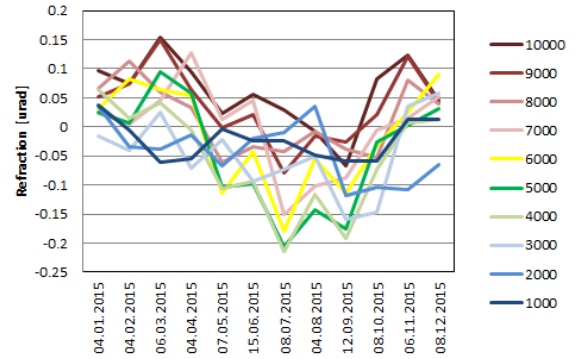
Figure 6. Seasonal change of the atmospheric refraction contribution by trace gases (CO 2 and H 2 O) in Tucson AZ at different camera height over ground (1000 m – 10000